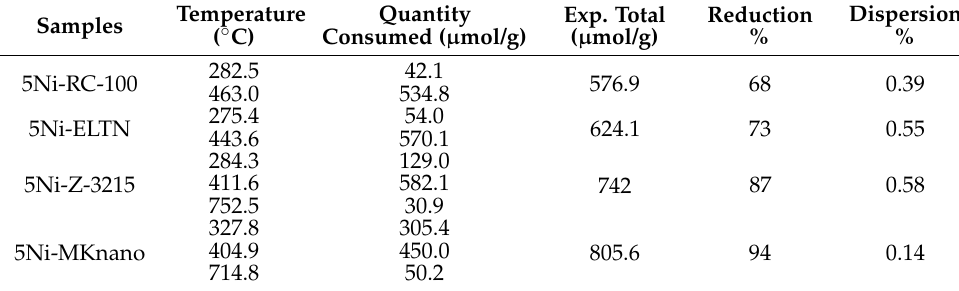
Table 2. The analysis of H 2 consumption during H 2